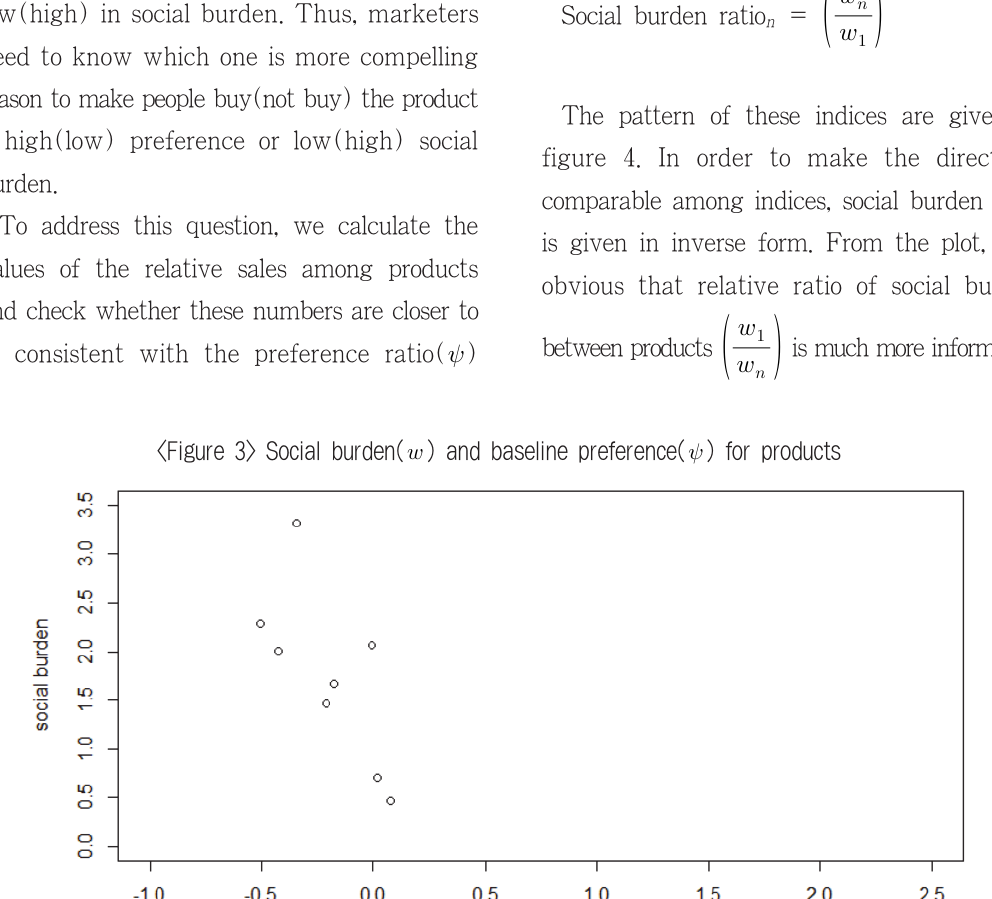
figure 4. In order to make the